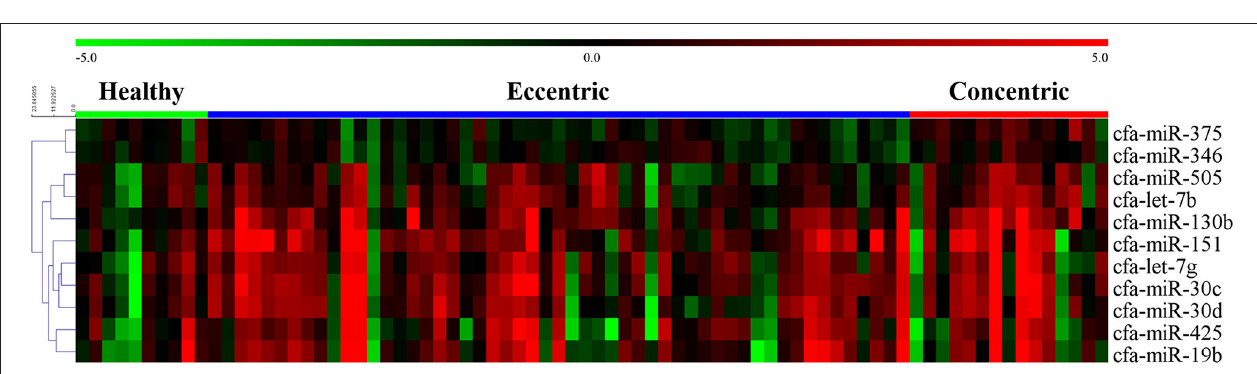
FIGURE 6 | Heat map of overall miRNA expression according to cardiac hypertrophy type. Sample species shown at the top and the miRNA species shown on the right. Unsupervised average link hierarchical clustering of miRNAs with similar expressions using the Euclidean distance measure. Red indicates relatively high expression of miRNA, and green indicates low expression of